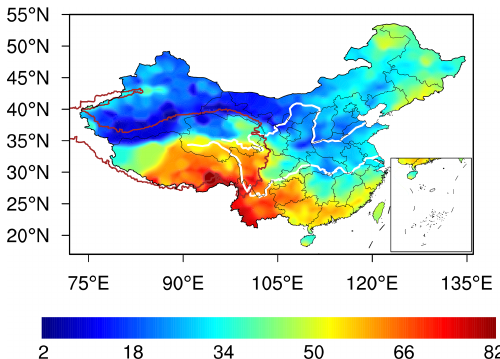
Figure 2. The summer mean LCC derived from surface observa- tions from 1951 to 2019 in China. The thick red contour denotes the 2.5km topography height referred to as the TP. The white lines located in the northern and southern parts of China denote the Yel- low and Yangtze rivers, respectively.